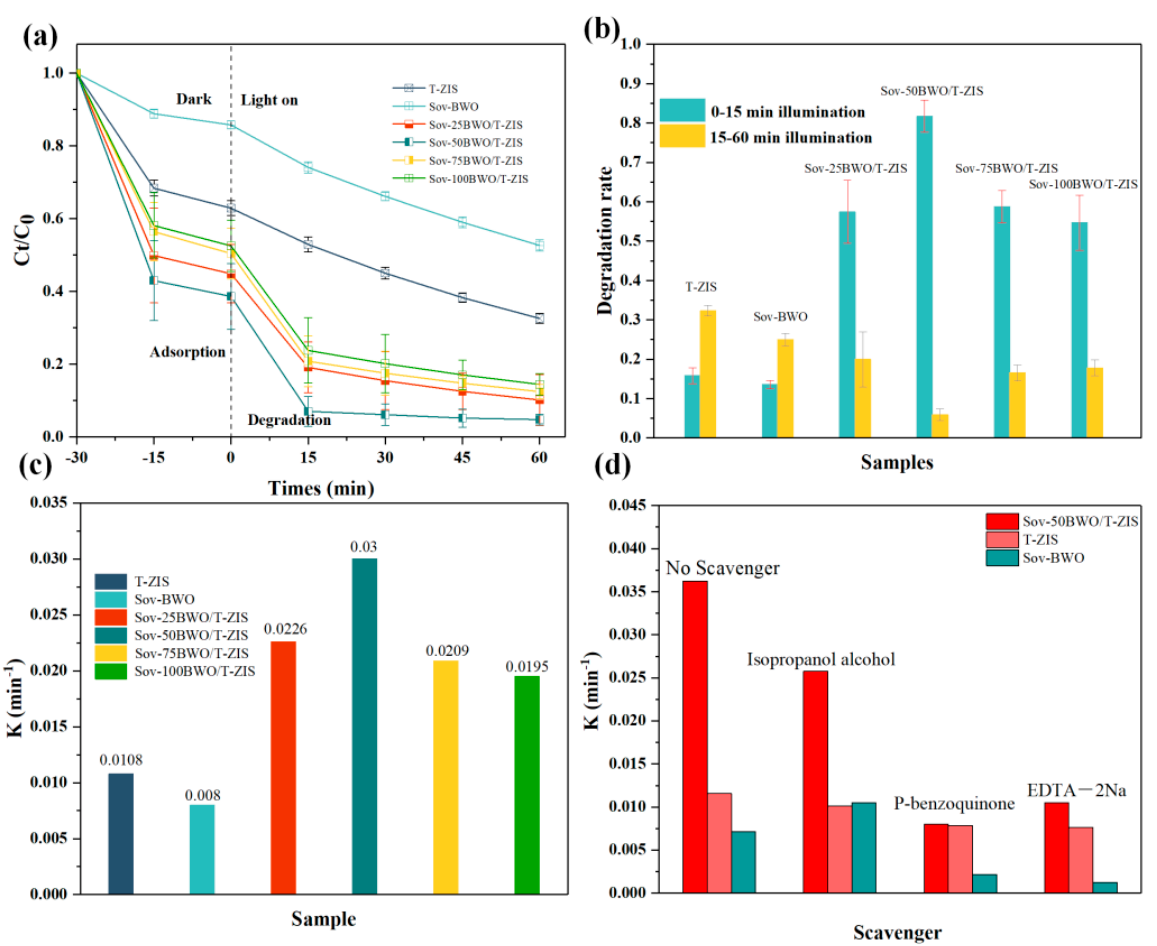
Figure 3. ( a ) TCH removal curves of as-prepared samples under visible light ( λ > 400 nm). ( b ) Effect of illumination time on the degradation efficiency. ( c ) Kinetics of photocatalytic degradation. ( d ) TCH removal efficiency with different scavengers.